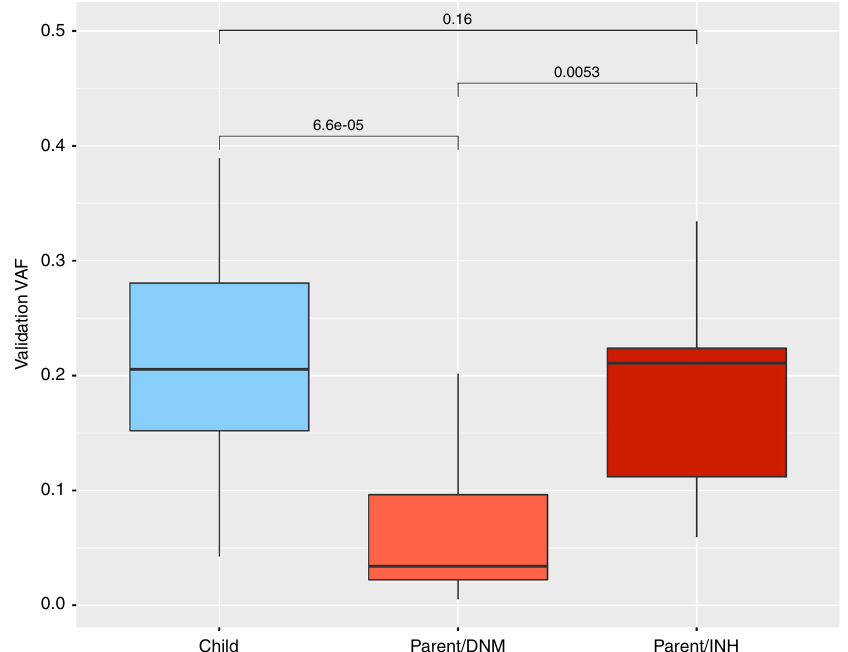
Fig. 6 Levels of mosaicism across validation experiments Boxplot of estimated level of mosaicism in validated mosaic DNMs, expressed as the variant allele fraction (VAF) from ultrahigh-depth sequencing, in the proband (blue) versus the parents (red). Parental variants are split into two distinctive groups: ‘ low level ’ (Parental/DNM, light red), which may be erroneously mistaken for DNMs in the child, and ‘ high level ’ (Parental/INH, dark red), which may be erroneously mistaken for constitutively inherited variants. P -values calculated using a Mann – Whitney – Wilcoxon test in R . Centre line = median; bounds of box = interquartile range; whiskers = quartile ± 1.5 × interquartile